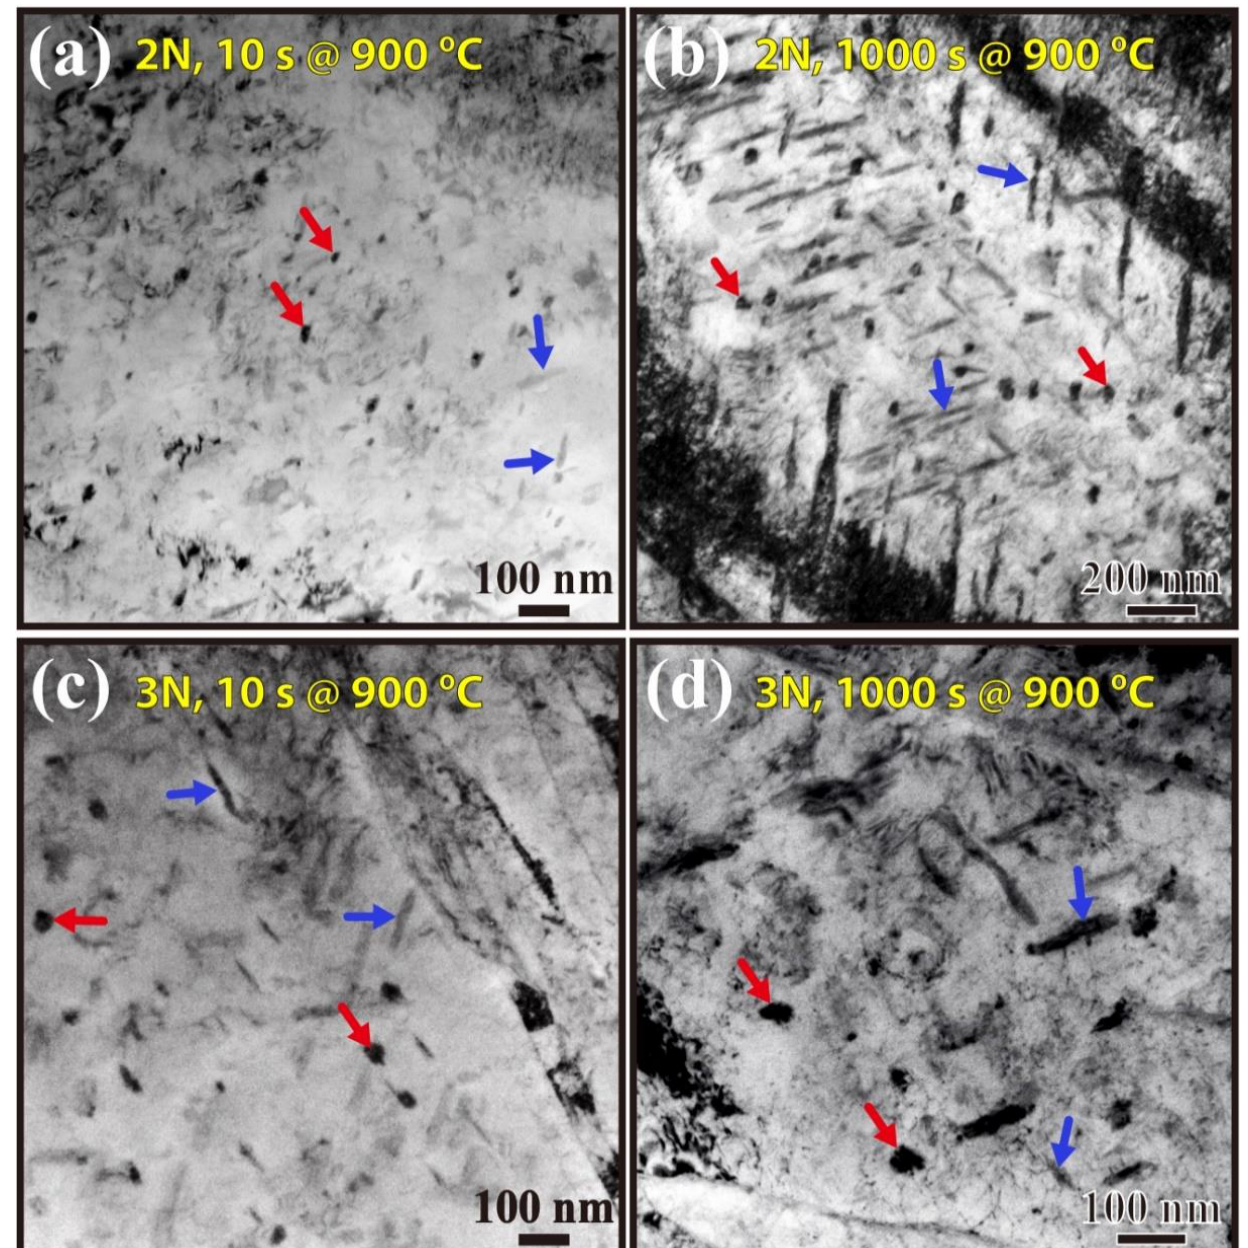
Figure 4. TEM bright-field images of precipitates with two kinds of morphology in martensite matrix: ( a ) Steel 2N treated at 900 °C for 10 s; ( b ) Steel 2N treated at 900 °C for 1000 s; ( c ) Steel 3N heat treated at 900 °C for 10 s; ( d ) Steel 3N treated at 900 °C for 1000 s.